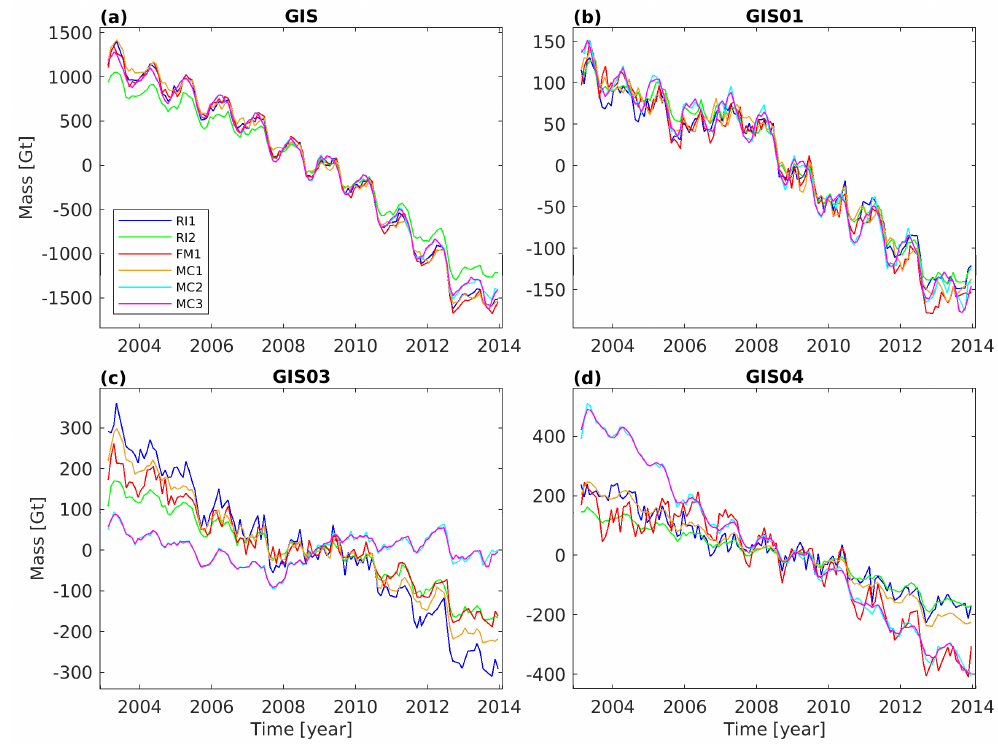
Figure 9. GRACE-derived mass change time series for ( a ) the entire Greenland Ice Sheet (GIS) as well as the drainage basins ( b ) GIS01 (North Greenland), ( c ) GIS03 (East Greenland) and ( d ) GIS04 (South-east Greenland). Figure 1 gives an overview of all drainage basins. The colour coding indicates the results from different groups (Table